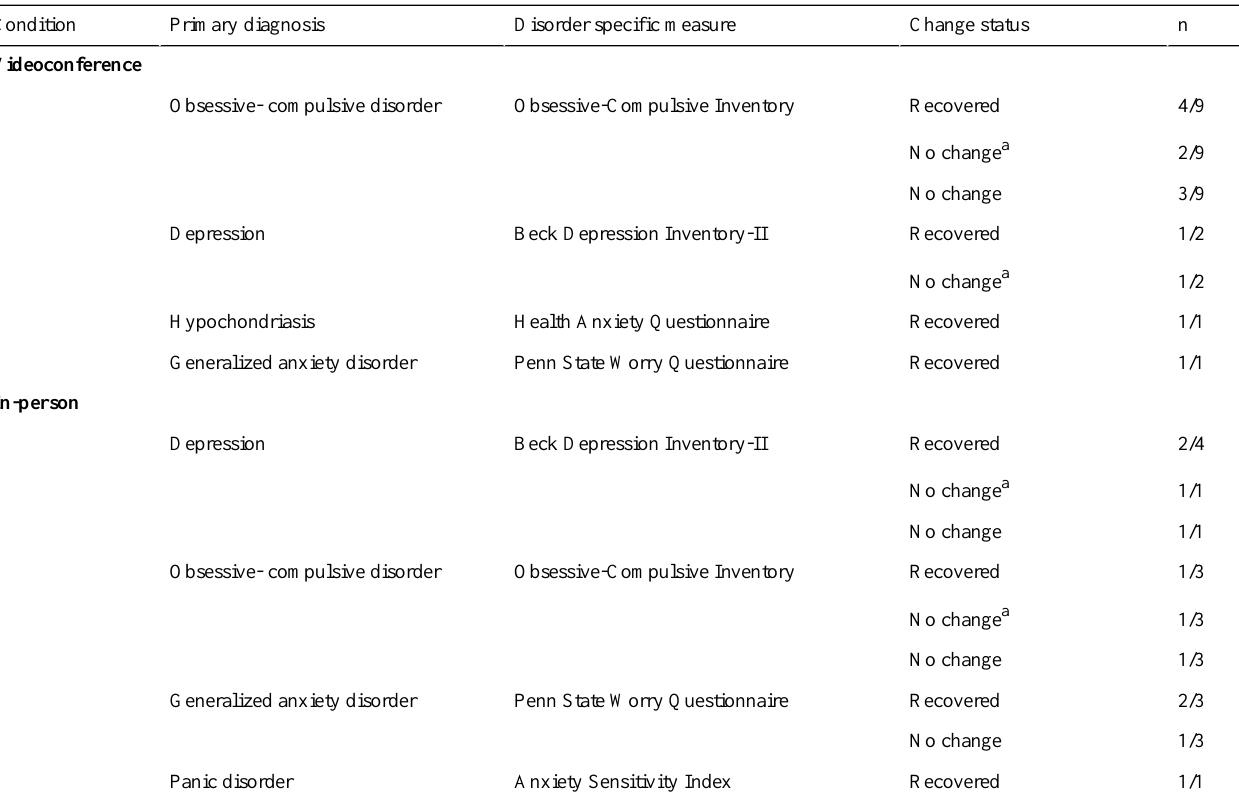
Table 7. The number of clients in each condition identified as recovered on the disorder specific measures.